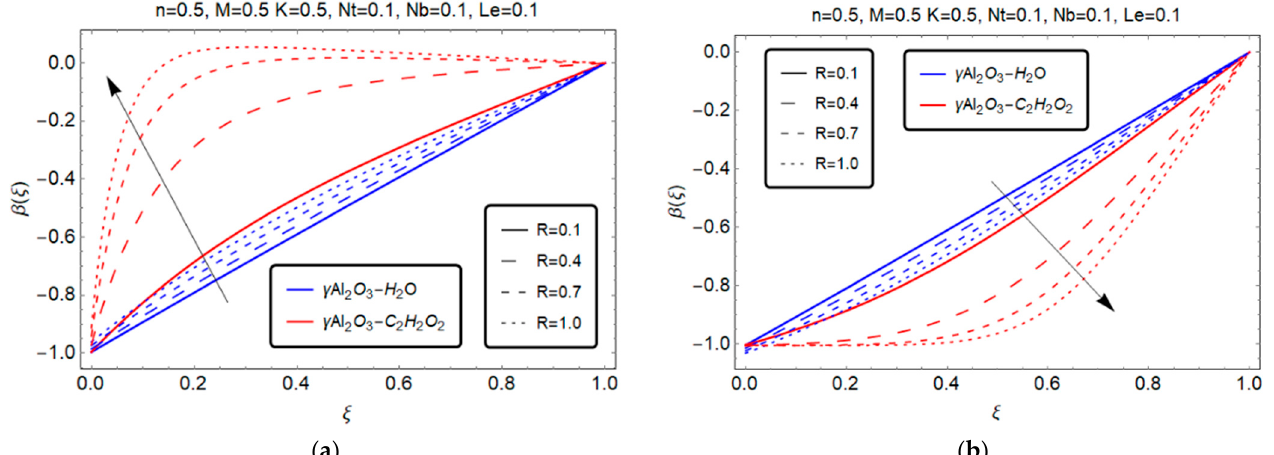
Figure 10. Effect of Reynold number R on 𝛽(𝜉) . ( a ) S > 0; ( b ) S < 0.